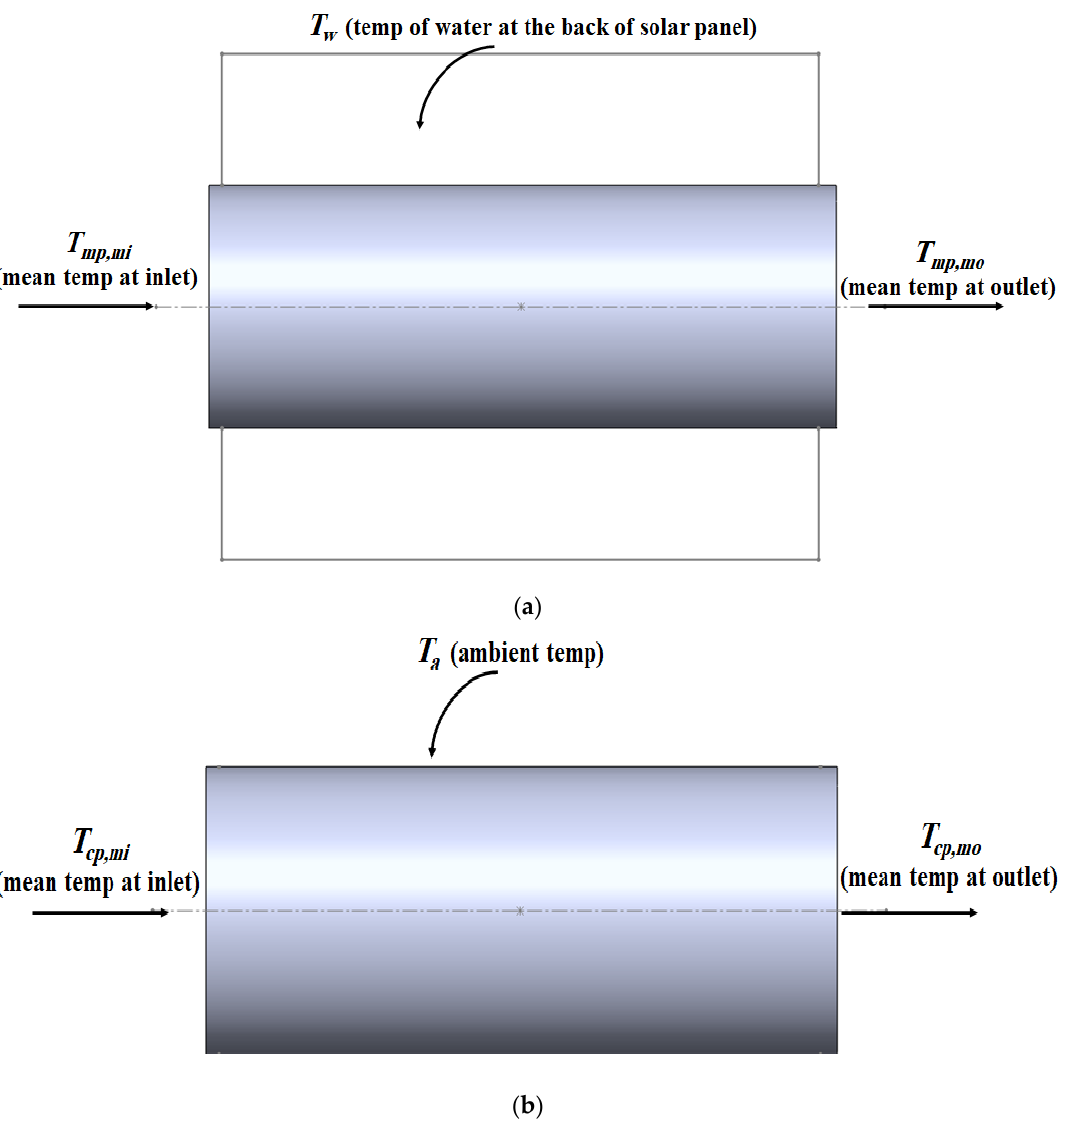
Figure 3. Inlet, outlet, and surrounding temperatures at the ( a ) main pipe (surrounded by hot water) and ( b ) connecting pipe (surrounded by ambient air).